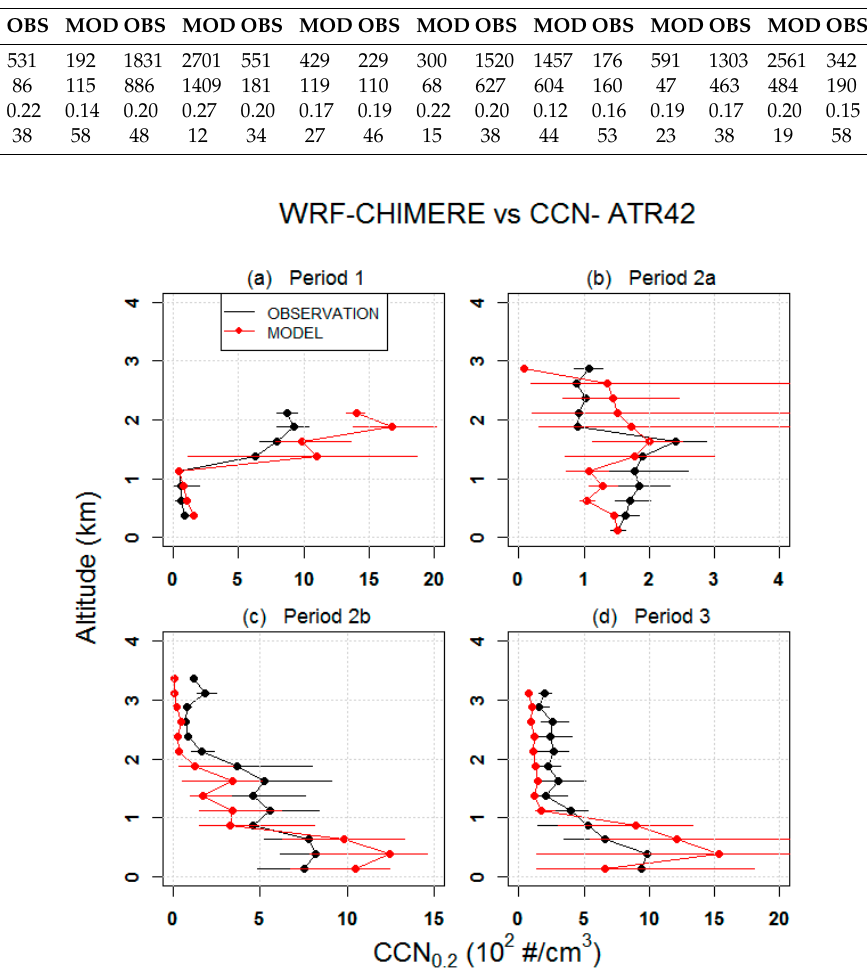
Figure 7. As in Figure 5, but for observed and simulated cloud condensation nuclei (CCN) at 0.2% of supersaturation.